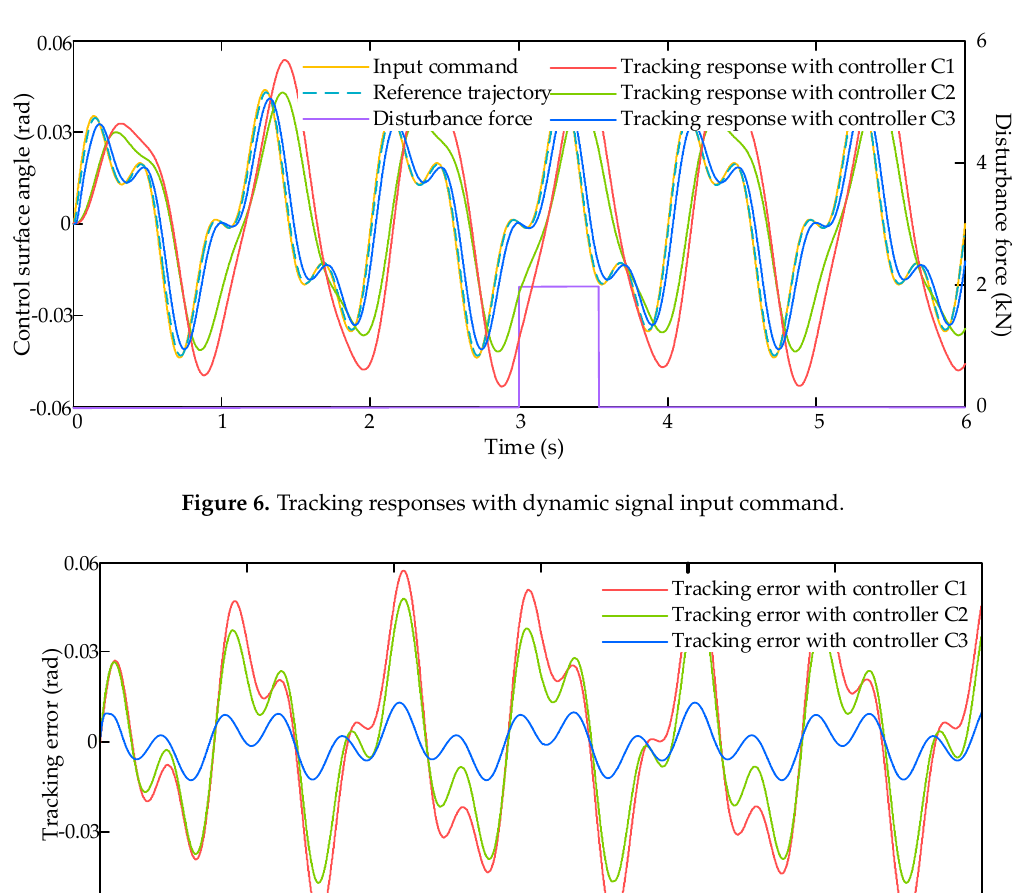
Figure 5. Force fighting results with step signal input command.